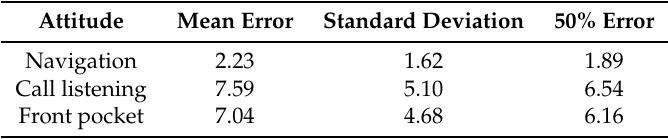
Table 4. Results statistics for various attitudes of the